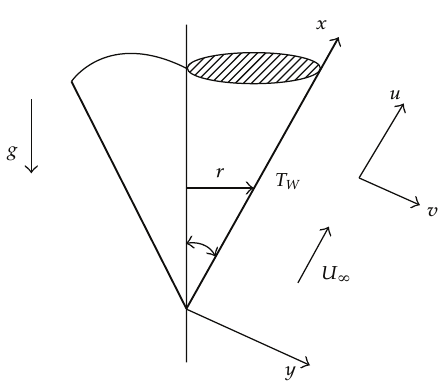
Figure 1: Schematic diagram of the